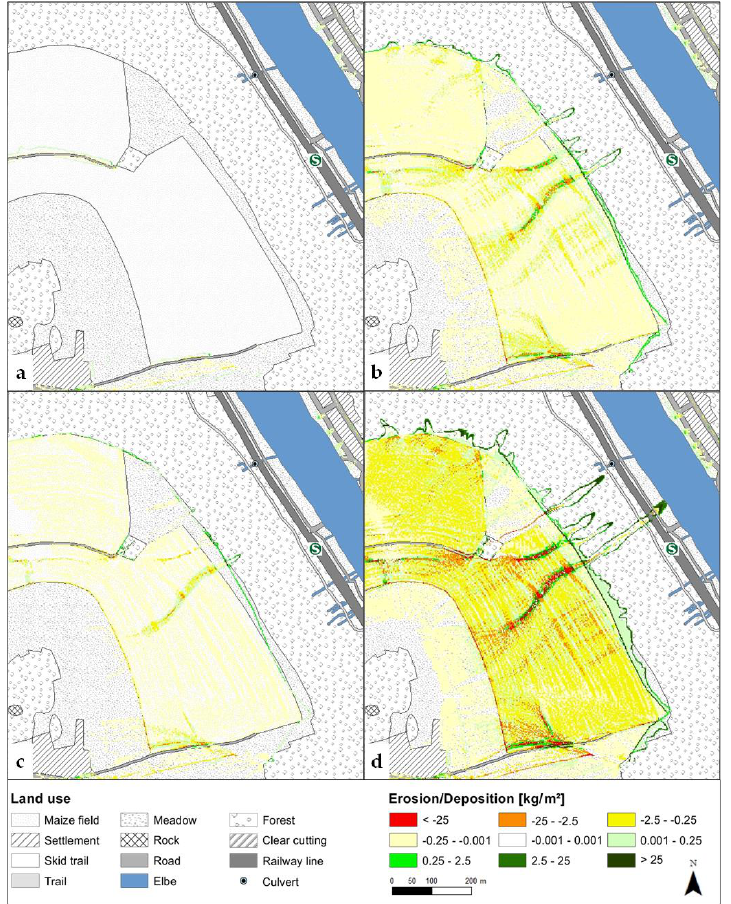
Figure 13. The erosion risk map with ( a ) RY- and ( b ) RZ-product for 23 May 2016 and for 31 May 2016 ( c , d ), respectively, for an undisturbed forest.